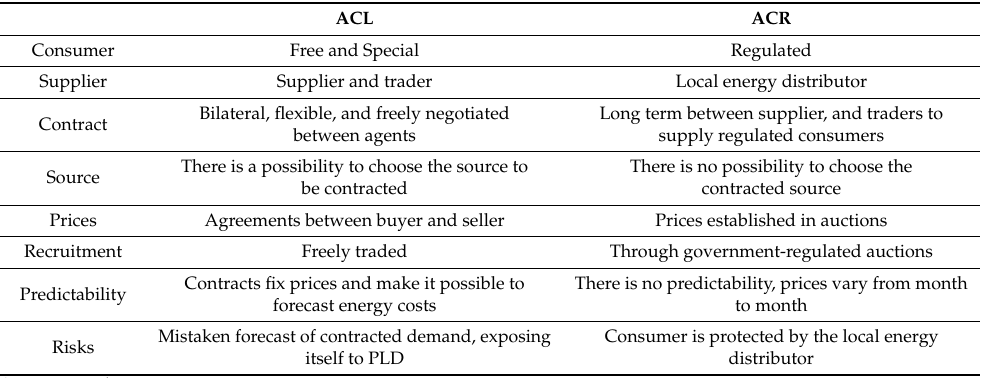
Table 2. Comparison between electric energy contracting environments in